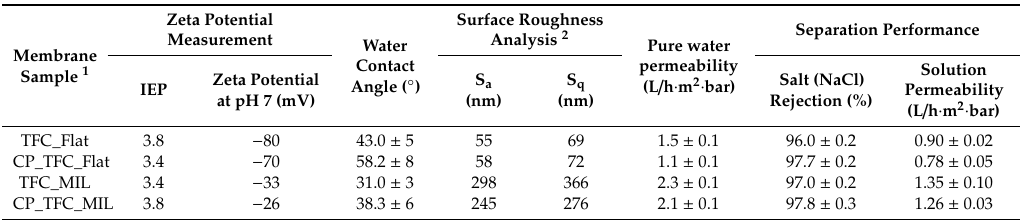
Table 2. Main characteristics and separation performance of flat and micro-patterned membranes employed in this study. IEP—isoelectric